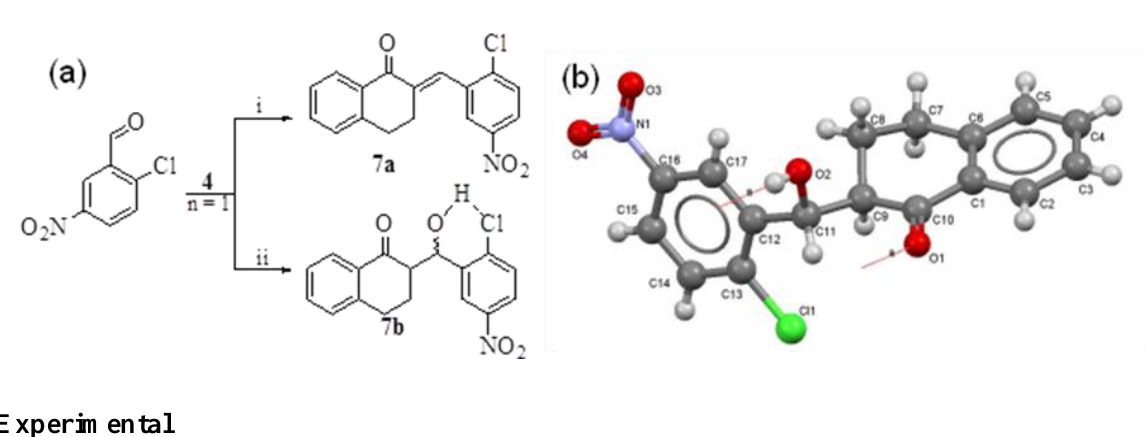
Figure 2. ( a ) Formation of 7a and 7b under different reaction conditions: i ) NaOH reflux ( 7a , 43%), SF ( 7a , 71%); SSA ( 7a , 82%); ii ) H